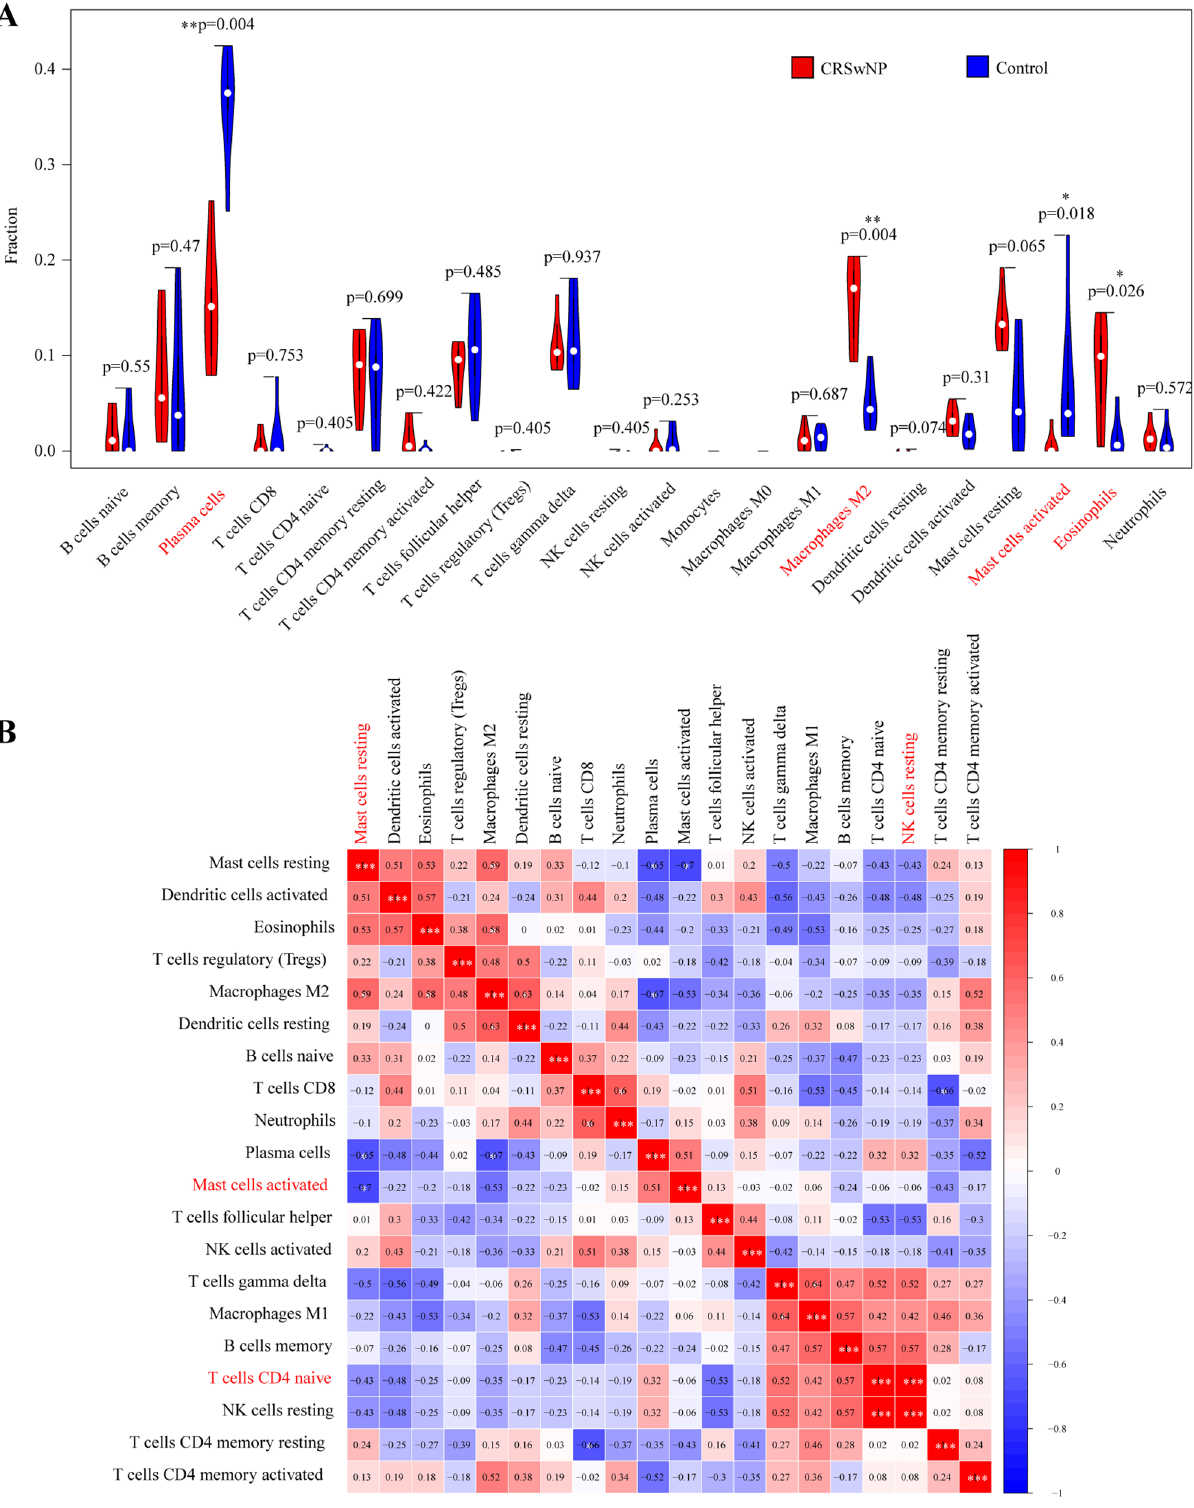
Figure 6. The landscape of immune infiltration between CRSwNP and normal controls. ( A ) Violin diagram of the proportion of 22 types of immune cells. ( B ) Correlation heatmap of 22 types of immune cells. Red: positive correlation; blue: negative correlation. Correlation heatmap were generated using R package “corrplot” (version 0.84. https:// github. com/ taiyun/ corrp lot). * p value < 0.05, ** p value < 0.01, *** p value <